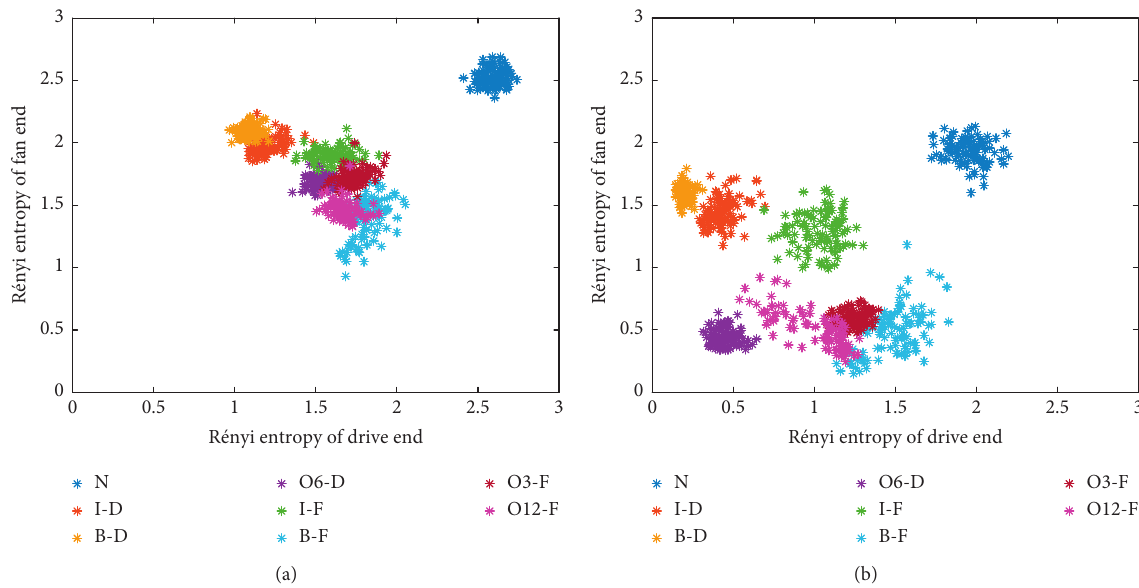
Figure 8: R´enyi entropy distributions of (a) raw data and (b) after autocorrelation